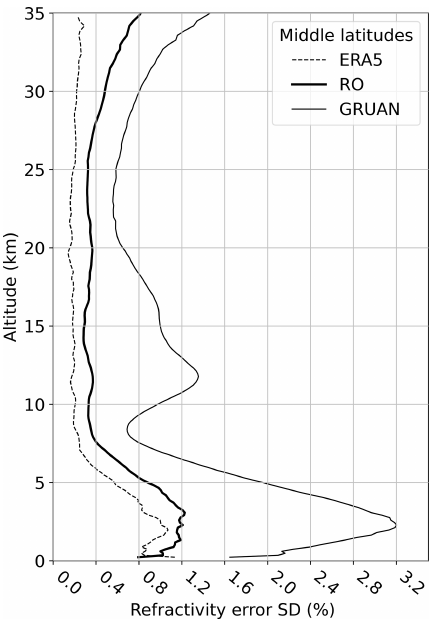
Figure 3. Raw estimate of refractivity random uncertainty (standard deviation) of ERA5, RO, and RS92 at middle latitudes.